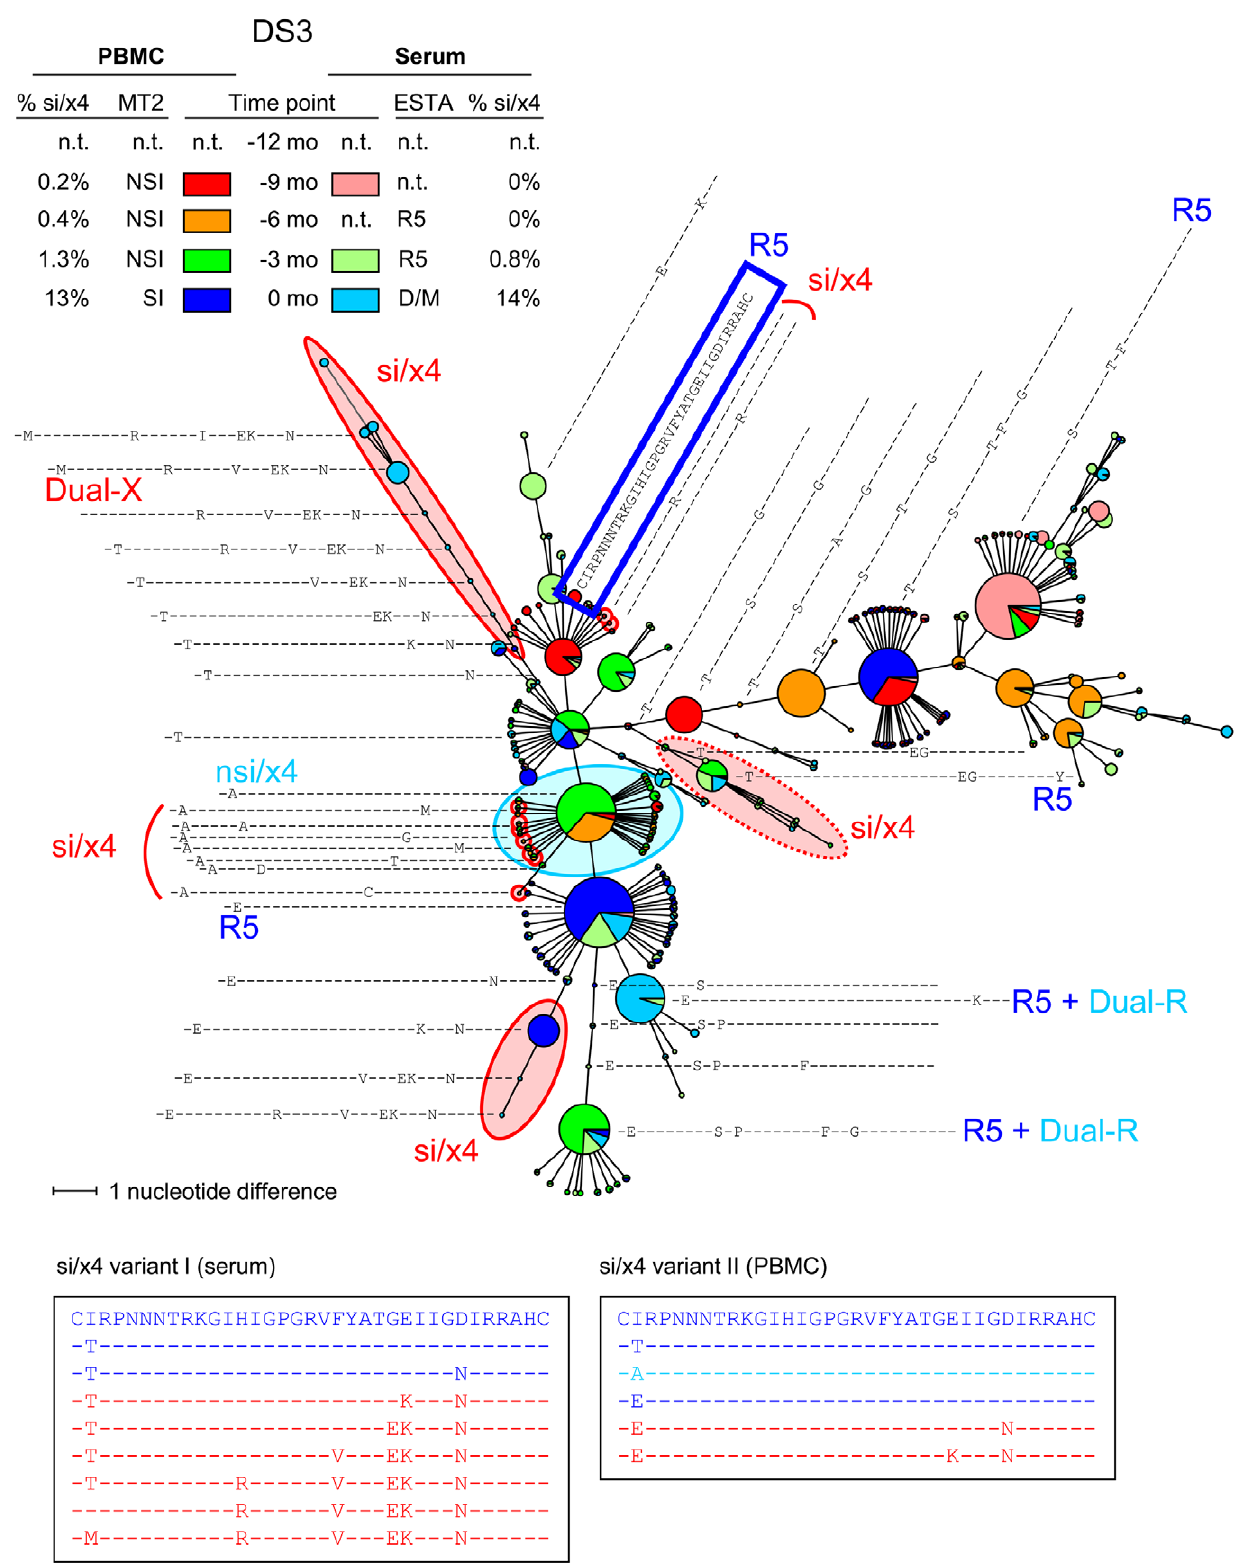
Figure 5. Multiple si/x4 variants emerge in subject DS3. An MST of all V3 sequences generated from PBMC and serum samples of all time points is shown. See the legend to Figure 3 for details regarding the layout of the figure. Nodes containing V3 sequences with an si phenotype as inferred by PSSM NSI/SI and an x4 phenotype as inferred by geno2pheno [coreceptor] are indicated in red, nodes containing discordant nsi/x4 variants are indicated in light blue, while all other sequences were predicted to be nsi/r5. Two distinct si/x4 branches and several minor si/x4 variants can be